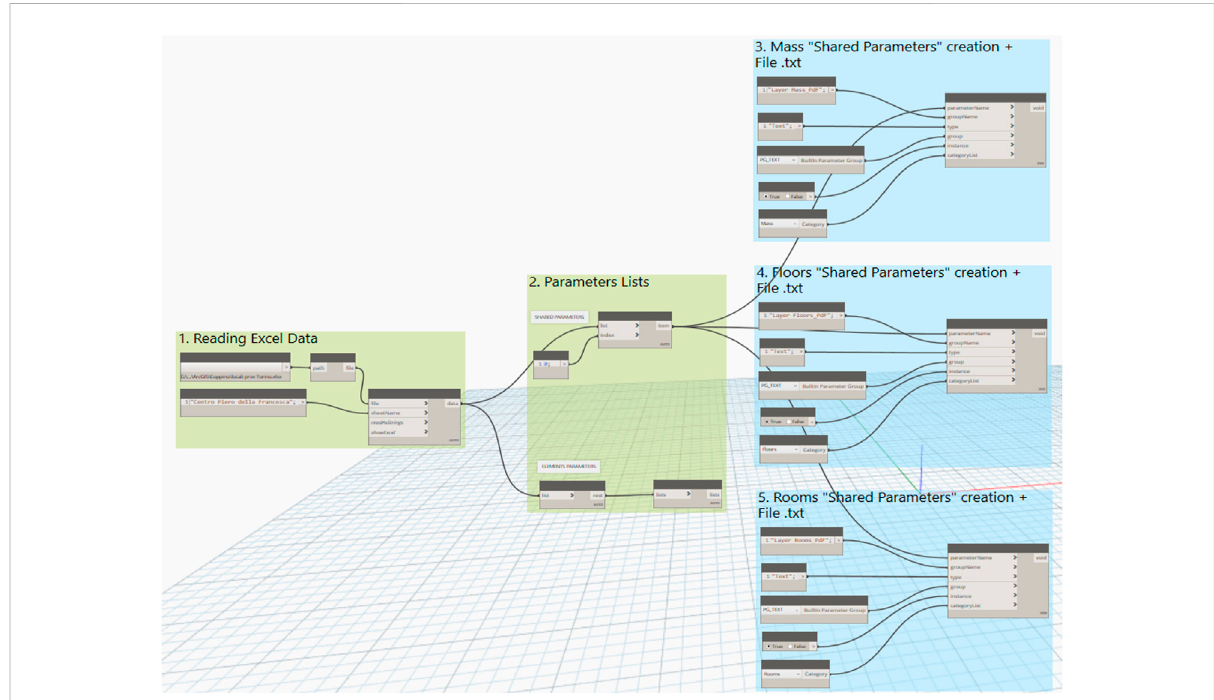
FIGURE 3 Dynamo work fl ow to import alphanumerical databases to parametric model elements.